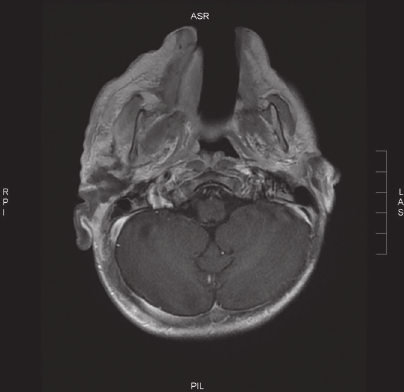
Figure 4: T1 MRI with gadolinium contrast showing significant inflammatory changes in the right ear canal, periauricular